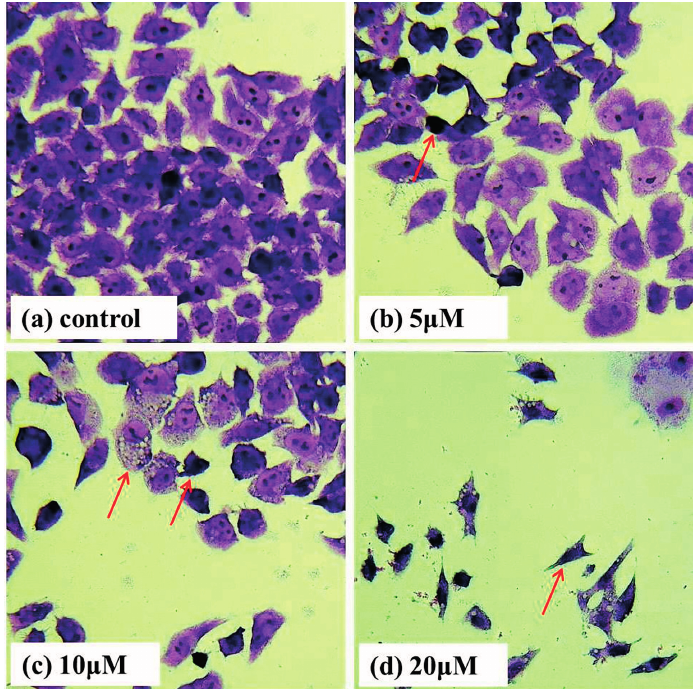
Figure 3. Morphological changes of Bel-7402 cells assessed by Giemsa staining. ( a ) Control group without T-OA; ( b ) Treated with 5 µM T-OA; ( c ) Treated with 10 µM T-OA; and ( d ) Treated with 20 µM T-OA.